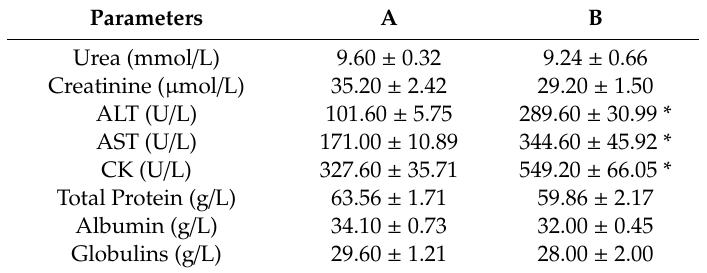
Table 4. Biochemical parameters (mean ± SEM) of female ICR mice in acute toxicity study of